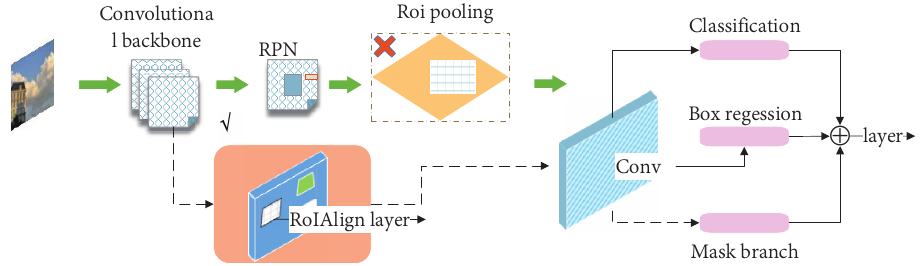
Figure 19. The framework of